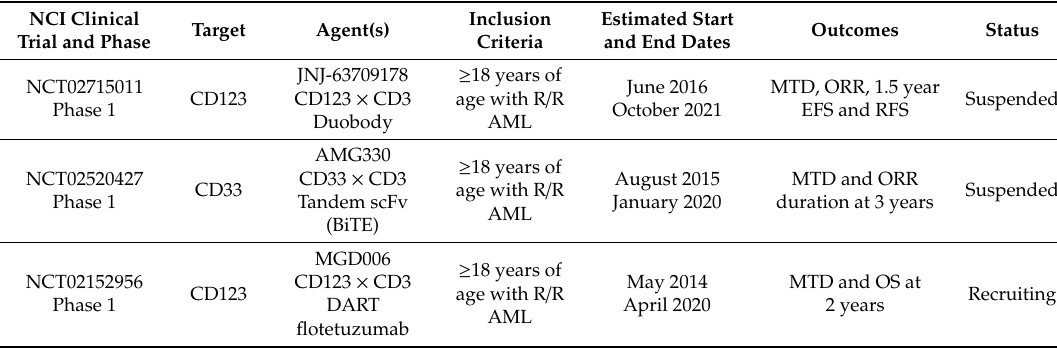
Table 1. Clinical trials of bispecific antibody therapy for